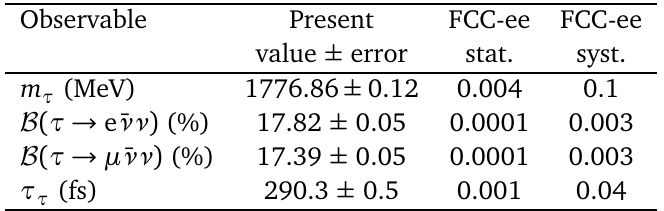
Table 4: Measurement of τ -lepton properties at FCC-ee, compared to the present precisions